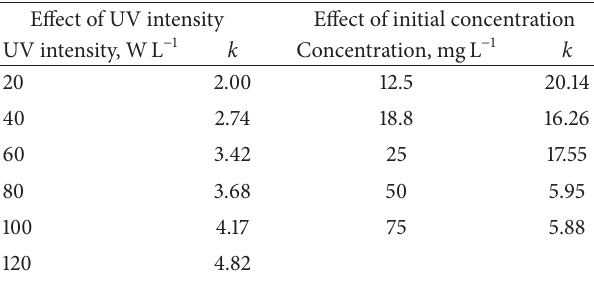
Table 2: The first-order reaction rate constant k (10 2 min − 1 ) for operating parameter of UV intensity and initial